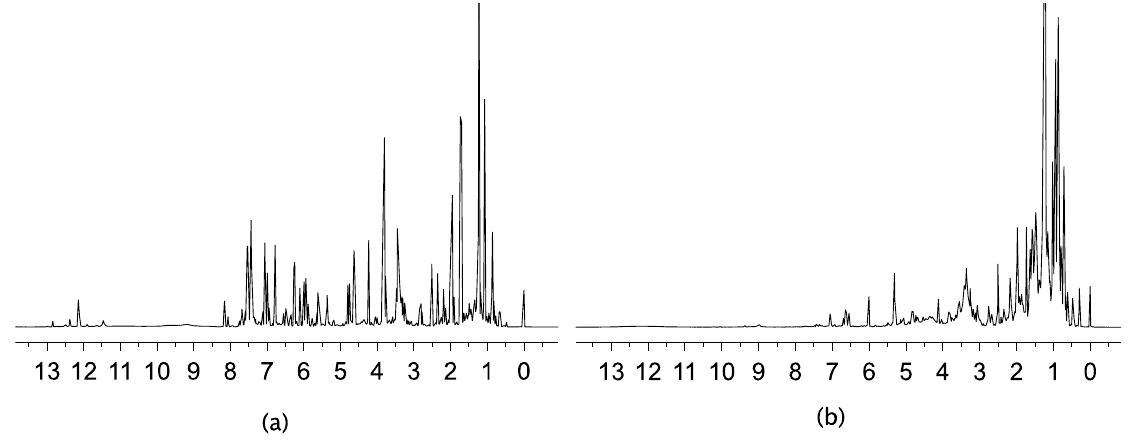
Figure 1. The 700-MHz 1 H-NMR spectra of 40 mg of propolis sample dissolved in 0.6 mL of DMSO- d 6 containing TMS. ( a ) Sample Puebla; Valsequillo 1 and ( b ) sample Puebla, Cuetzalan.